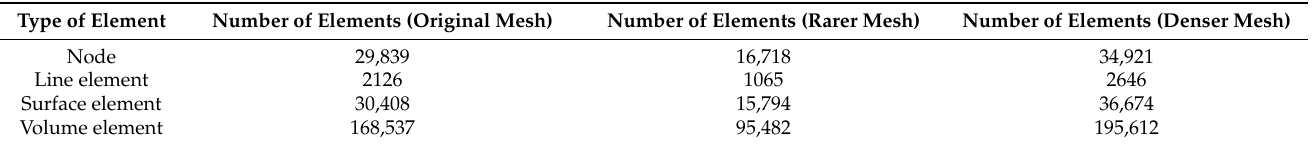
Table 3. Number of nodes, line elements, surface elements and volume elements for the three meshes used in the comparison. Type of Element Number of Elements (Original